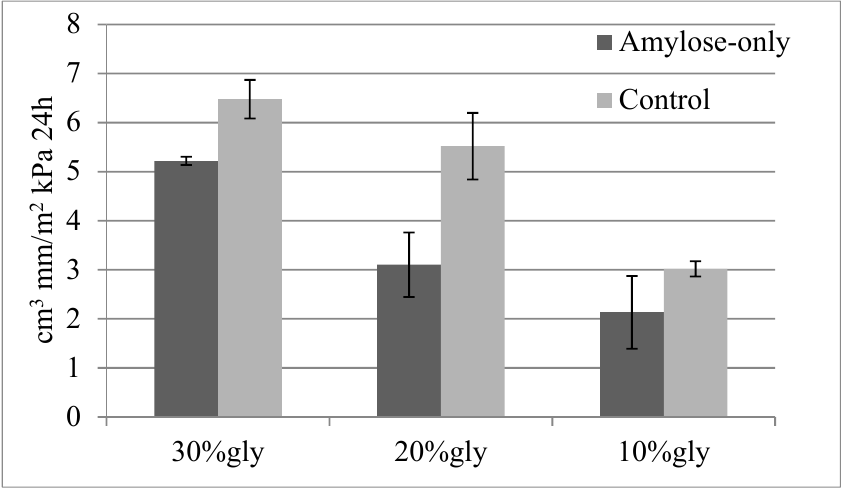
Figure 5. Permeability tested for non-crosslinked AO and control starch films as a function of glycerol content .